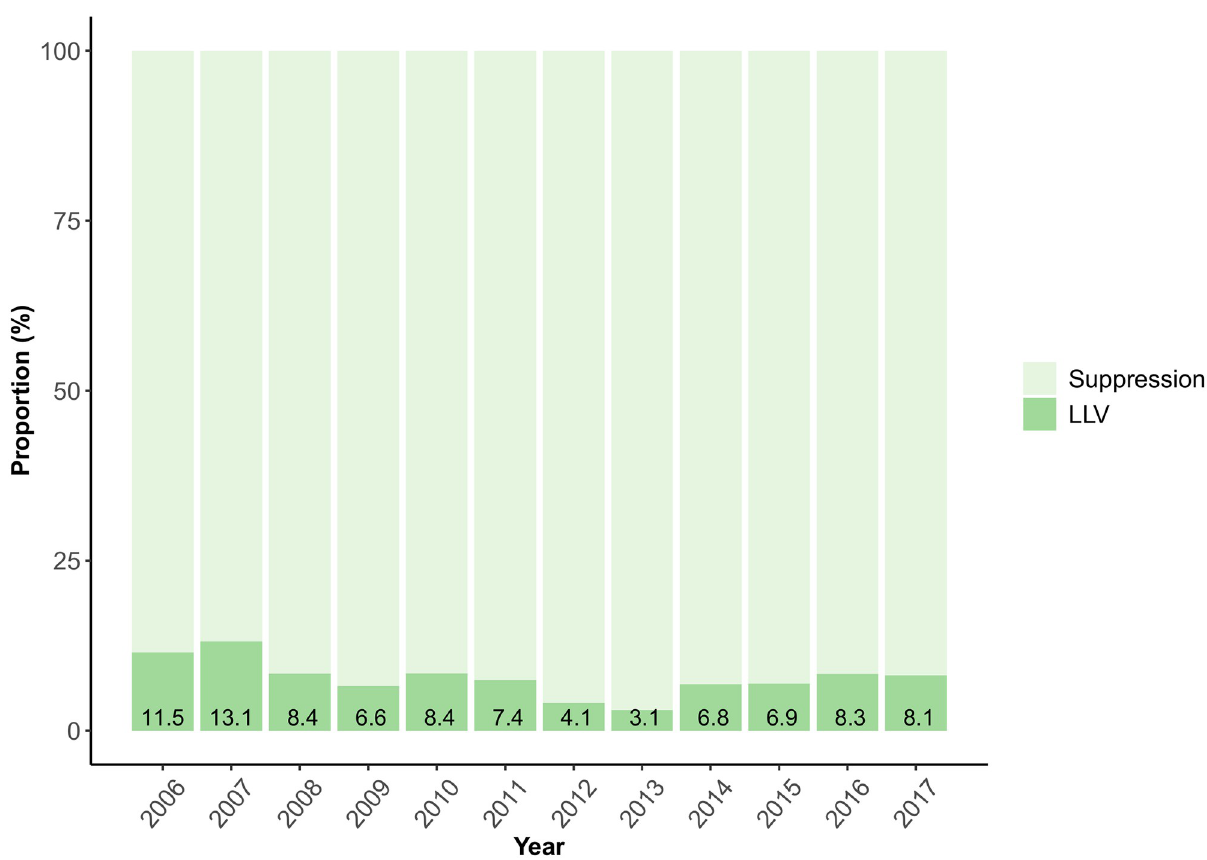
Fig 2. Proportion of study participants experiencing LLV during 6–30 months after start of ART, grouped by year of ART initiation. Abbreviations: ART, antiretroviral therapy; LLV, low-level viraemia.